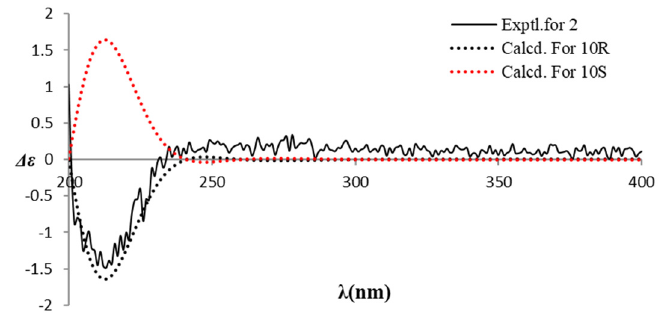
Figure 5. Experimental and calculated ECD spectra of compound 2 .